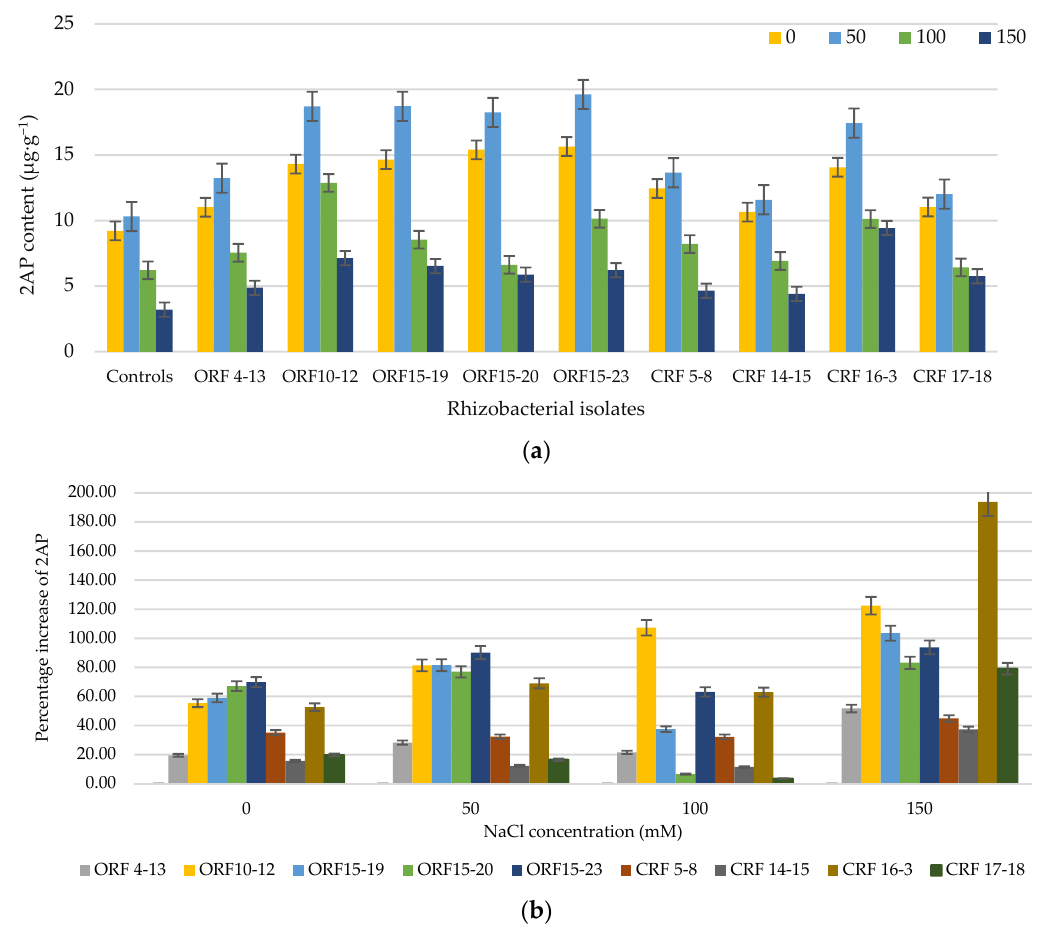
Figure 2. 2-Acetyl-1-pyrroline (2AP) content in fresh KDML105 rice leaves ( a ), and percentage increase in 2AP ( b ) at 30 days after transplanting under saline conditions (0, 50, 100, and 150 mM NaCl).